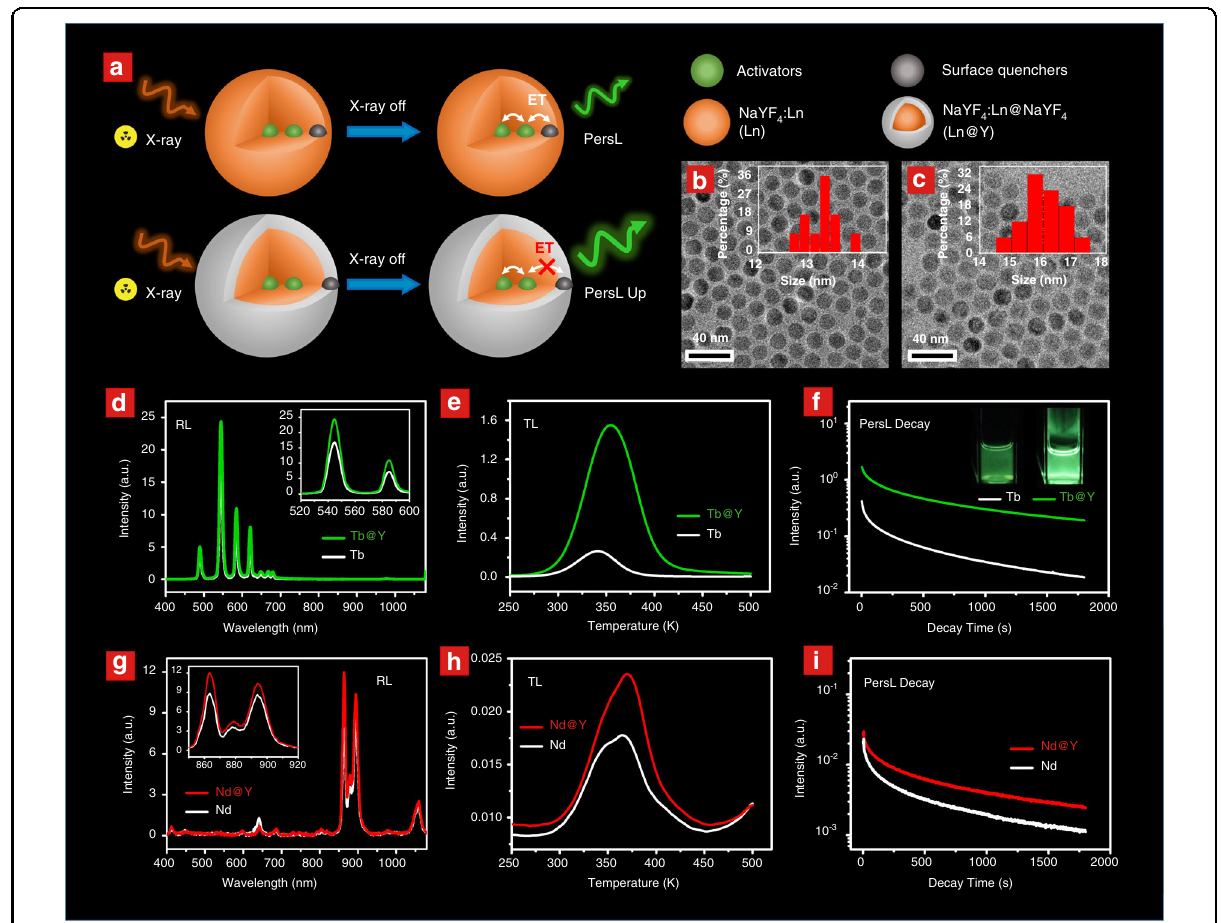
Fig. 1 PersL enhancement by the surface-passivated core – shell structure a Schematic illustration of the core – shell structure and proposed PersL enhancement mechanism. The description of particle components is given on the right side. b – c TEM images of NaYF 4 :Tb 3 + and NaYF 4 :Tb 3 + @NaYF 4 nanoparticles. The insets show the particle size distributions of the nanoparticles. d – f RL spectra ( d ), TL glow curves ( e ) and PersL decay curves ( f ) of NaYF 4 :Tb 3 + and NaYF 4 :Tb 3 + @NaYF 4 monitored in the range of 400 – 750 nm. The insert of ( f ) shows the PersL images of NaYF 4 :Tb 3 + and NaYF 4